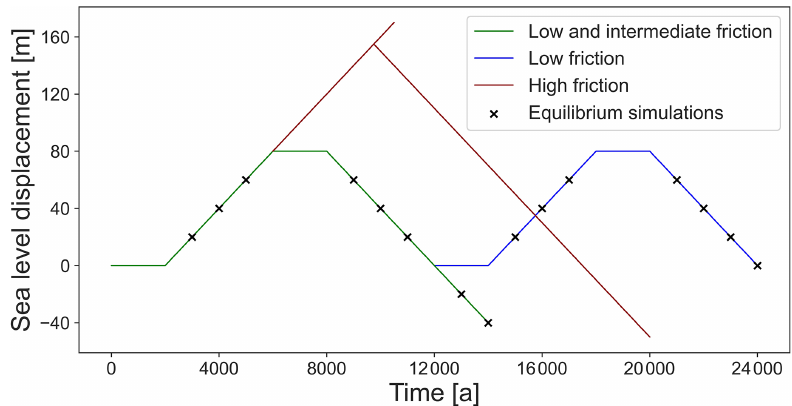
Figure 3. The change in sea level for the transient simulations. The low and intermediate scenarios follow the green curve. A second sea level increase-and-decrease cycle is performed for the low-friction scenario (blue). Sea level is increased to 170m in the high-friction scenario, and a separate sea level decrease branch is simulated from 155m (red curve). Sea level is increased and decreased at rates of ± 0.02ma − 1 . The crosses indicate points in the low-friction scenario at which a steady-state branch is started with constant sea level in order to compare to the transient simulation.